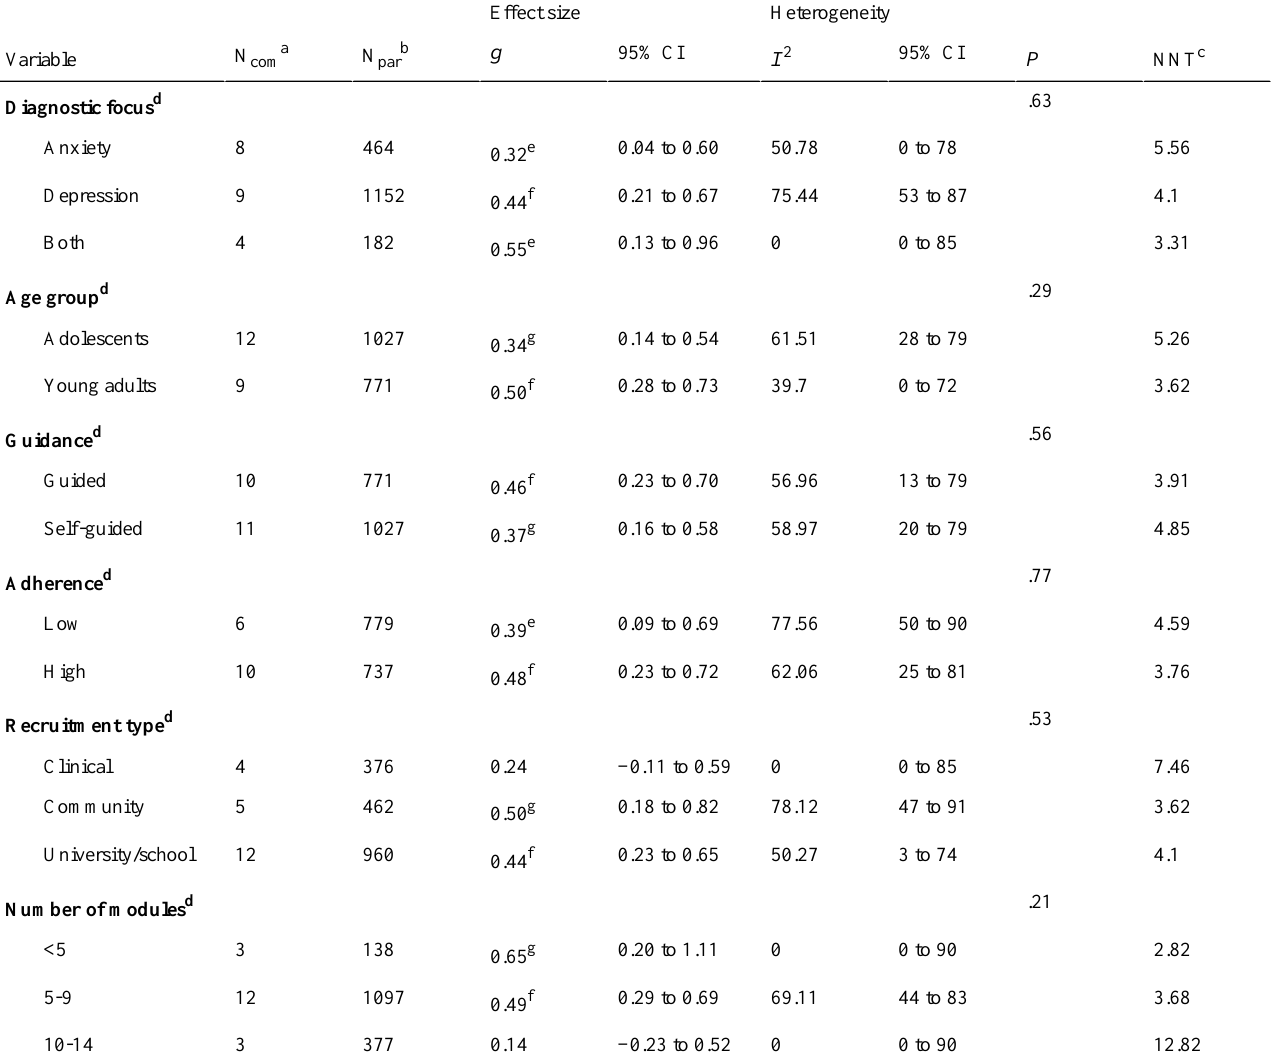
Table 2. Effect sizes regarding depressive symptoms in the subgroup analyses of studies comparing computerized cognitive behavior therapy in adolescents and young adults with active treatment and passive controls at